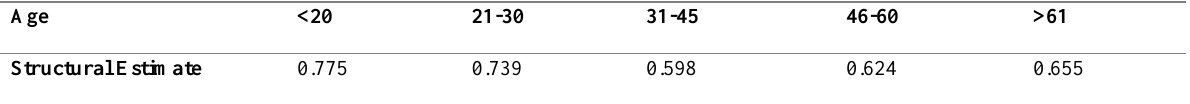
Table 1: Relationship among, number of alternatives forgone and post-purchase regret concerning Age